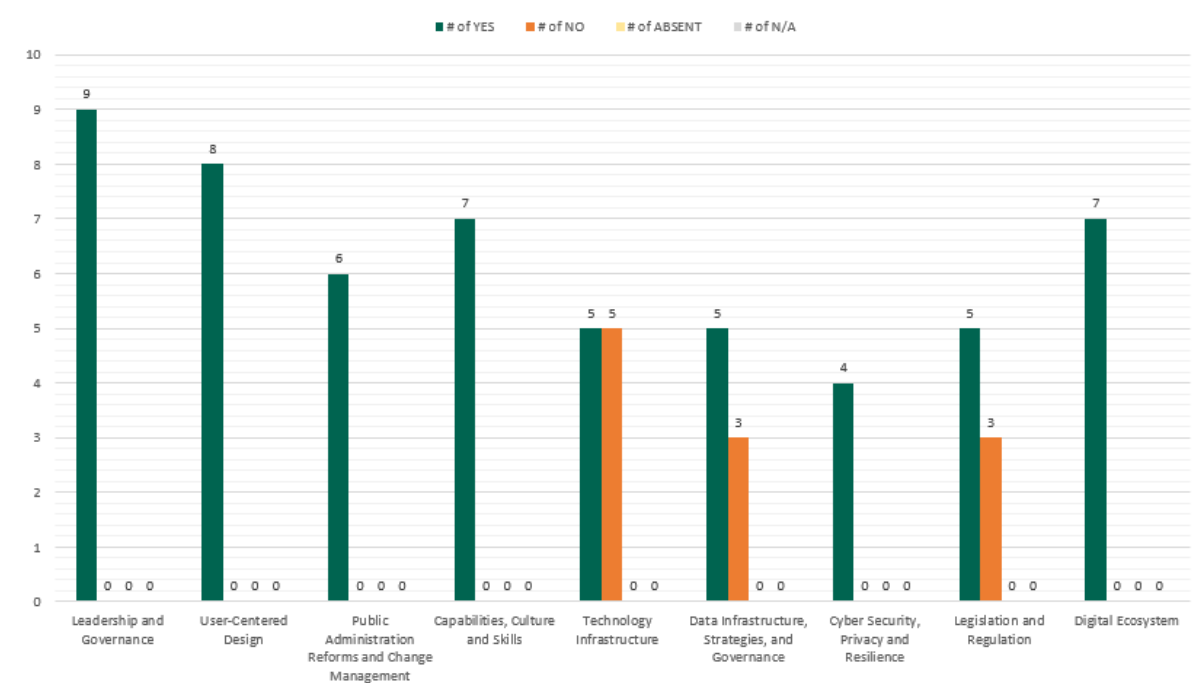
Figure 7. The DGRA results per section for land services in the Ministry of